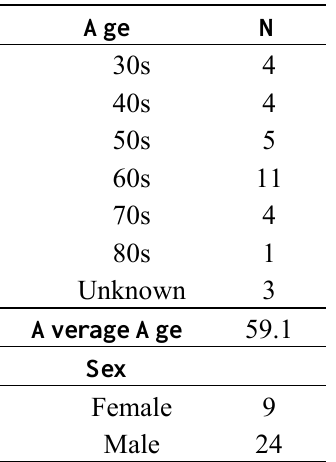
Table 1. Participant Characteristics ( n =